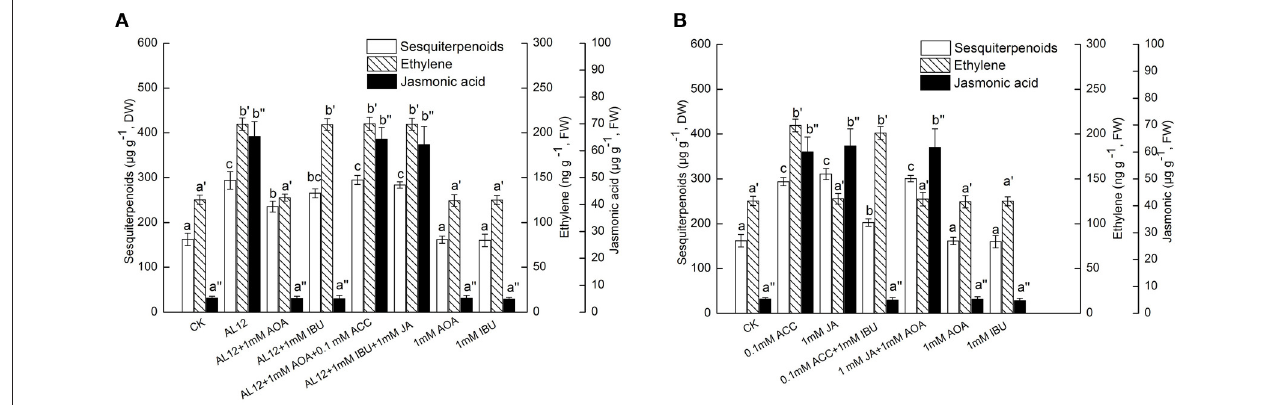
FIGURE 2 | (A) Interaction between ethylene and JA signaling pathways for endophytic fungus AL12-induced sesquiterpenoids accumulation in Atractylodes lancea plantlets. Thirty-day-old plantlets treated with 5-mm AL12 mycelial disks, 1 mM AOA, 1 mM IBU, 0.1 mM ACC, and 1 mM JA were harvested after 15 days to determine the sesquiterpenoids, ethylene and JA contents. Inhibitors were added 1 day prior to endophytic fungus AL12 inoculation or exogenous signal donor application. Controls were established using equal sized potato dextrose agar disks. Values are the means of three independent experiments ± SD. Bars with different lowercase letters (e.g., a, b, c; a ′ , b ′ , c ′ ; a ′′ , b ′′ , c ′′ ) are significantly different ( P < 0.05). (B) Dependence of ethylene-induced sesquiterpenoids accumulation on JA in Atractylodes lancea plantlets. Thirty-day-old plantlets treated with 0.1 mM ACC, 1 mM JA, 1 mM AOA, and 1 mM IBU were harvested 15 days later to determine the sesquiterpenoids, ethylene and JA contents. Inhibitors were added 1 day prior to exogenous signal donor application. Controls were established using equal volume of double distilled water. Values are the means of three independent experiments ± SD. Bars with different lowercase letters (e.g., a, b, c; a ′ , b ′ , c ′ ; a ′′ , b ′′ , c ′′ ) are significantly different ( P <